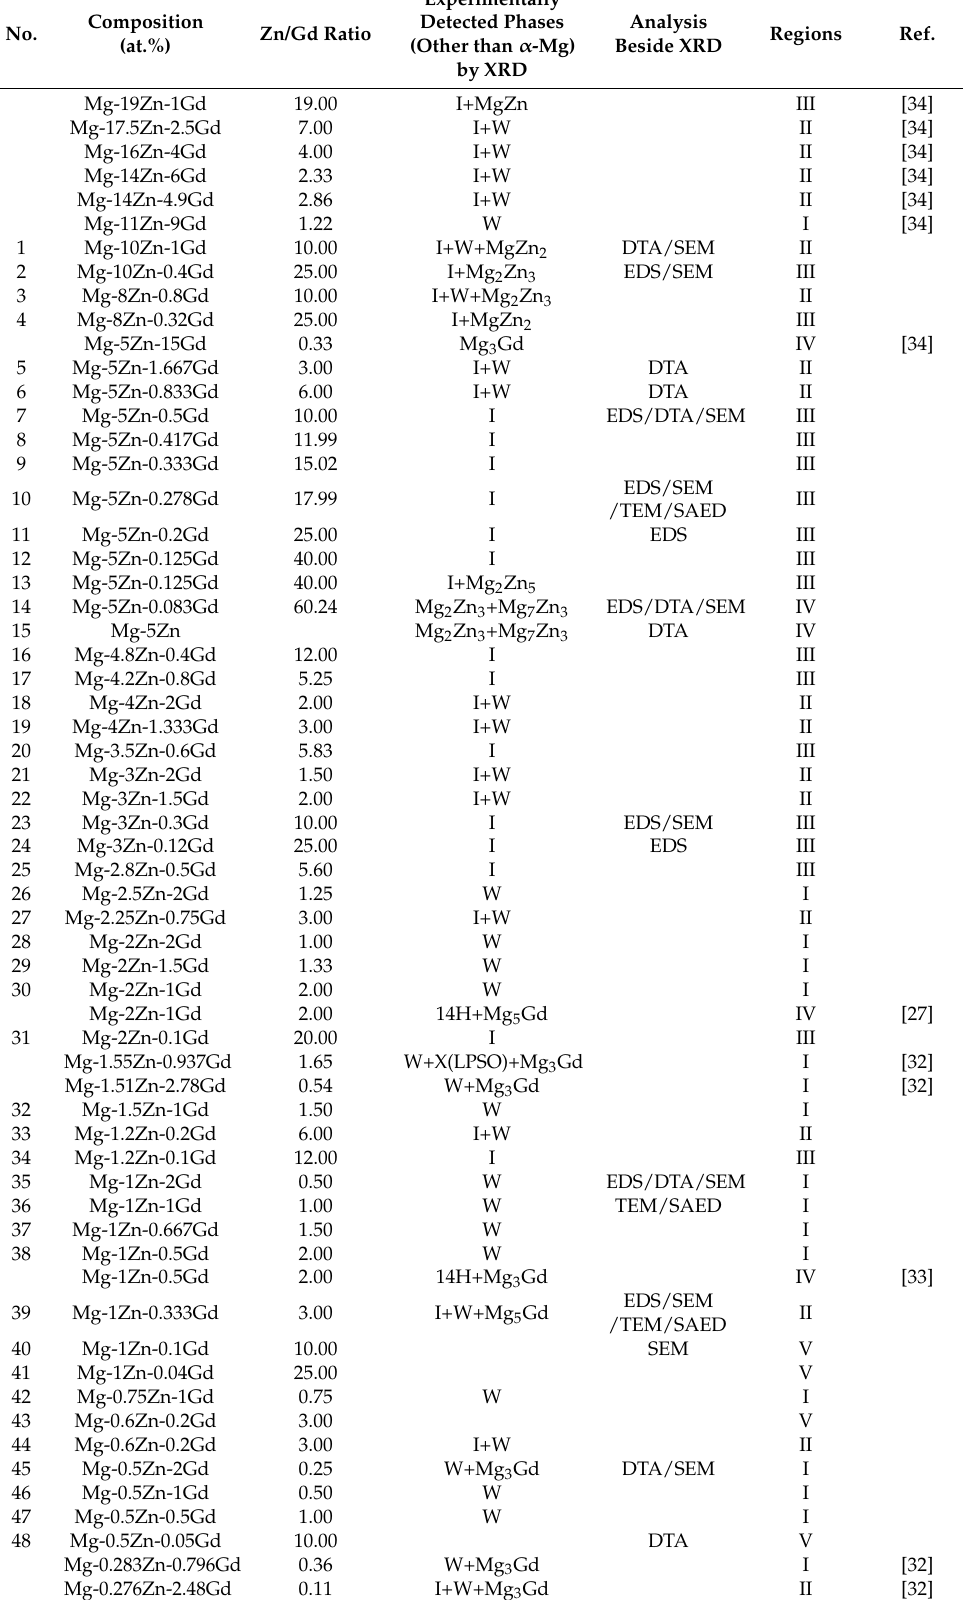
Table 1. The summary of the phase constitutions in Mg-Zn-Gd alloy with different compositions. Experimentally Detected Phases Analysis Composition Regions Ref. Zn/Gd Ratio No. (Other than α -Mg) Beside XRD (at.%) by XRD Mg-19Zn-1Gd 19.00